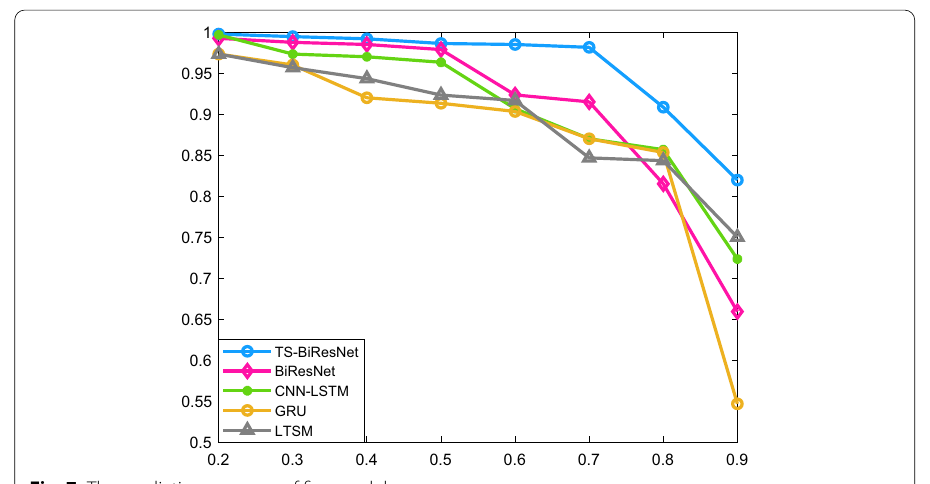
Fig. 7 The prediction accuracy of five models